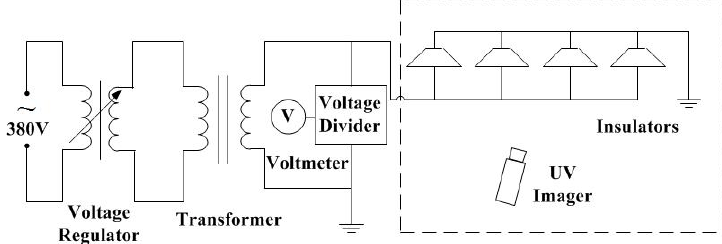
Figure 2. Schematic diagram of high voltage experiment.